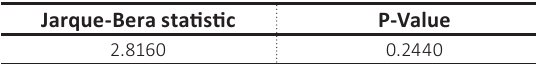
Table 3. Normality test results